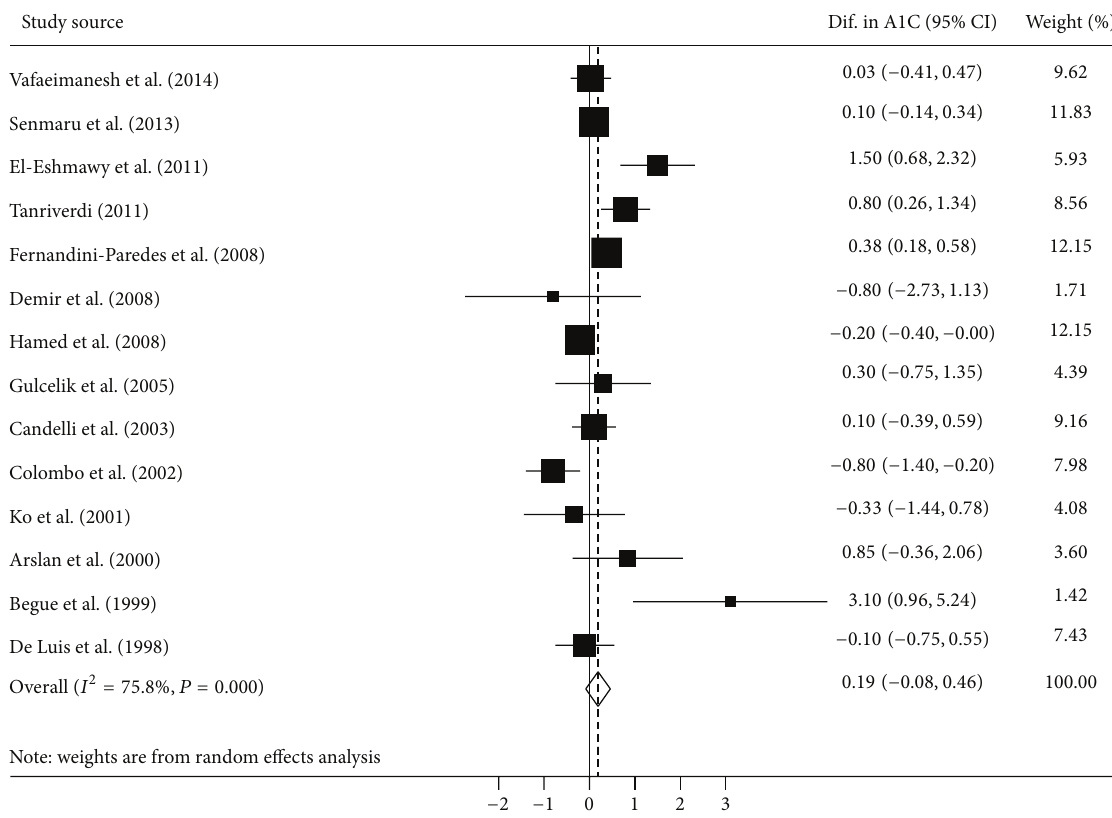
Figure 2: Forest plot of mean differences with corresponding 95% confidence intervals (CIs) in hemoglobin A1C (A1C) for patients with diabetes with Helicobacter pylori infection versus those with Helicobacter pylori noninfection. Size of squares reflects the statistical weight of each study. Pooled mean difference in A1C is indicated by an unshaded